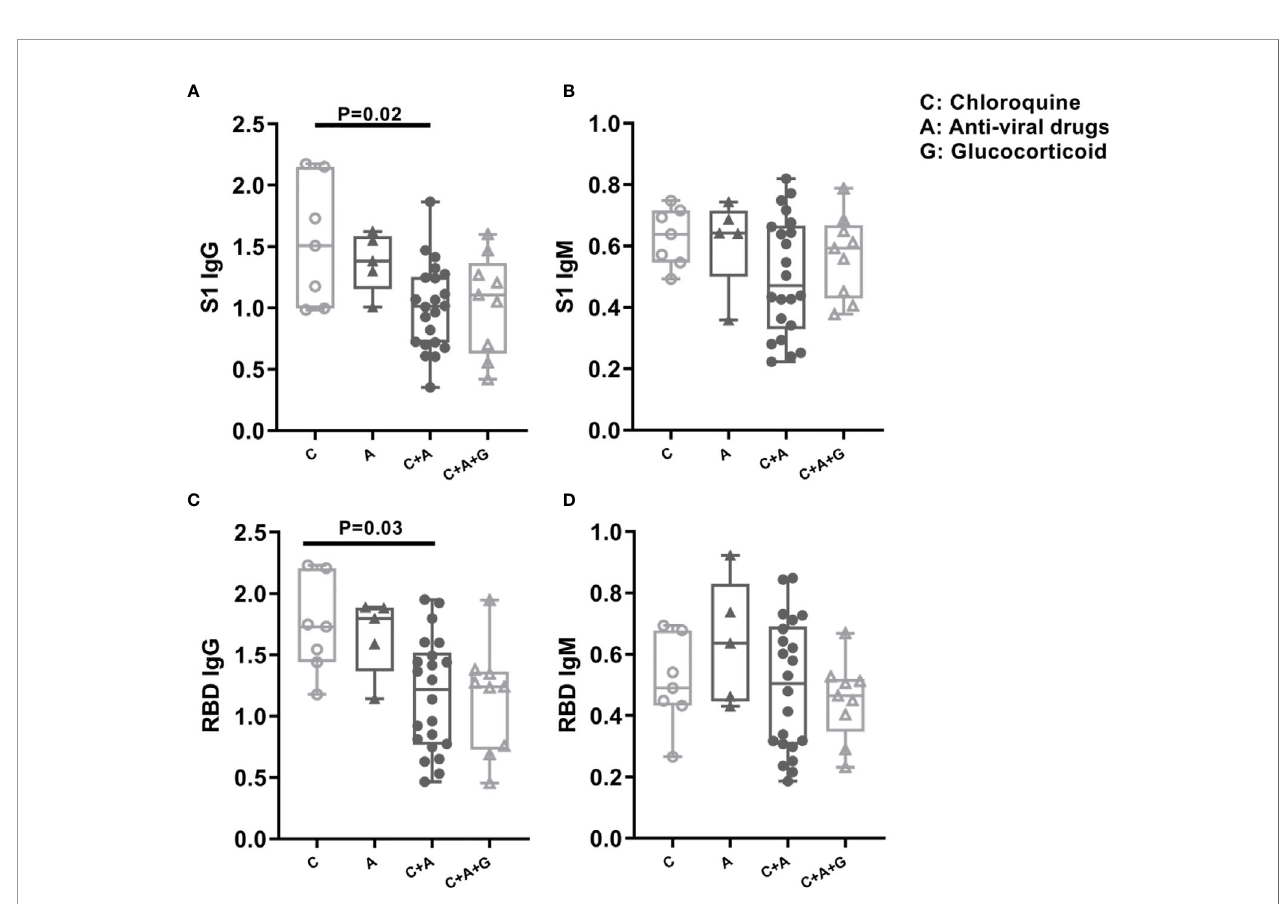
FIGURE 5 | The Difference of Patients ’ Antibody Titer after Chloroquine, Anti-viral Drug or Glucocorticoid Medication. The patients were grouped in chloroquine group, antiviral drug group, chloroquine plus antiviral drugs, chloroquine, antiviral drugs plus glucocorticoids group. The titers of IgG and IgM antibody against S protein (A, B) or RBD (C, D) between 8-21 days from symptom onset were collected and analyzed. C, Chloroquine; A, Anti-viral Drug; G,